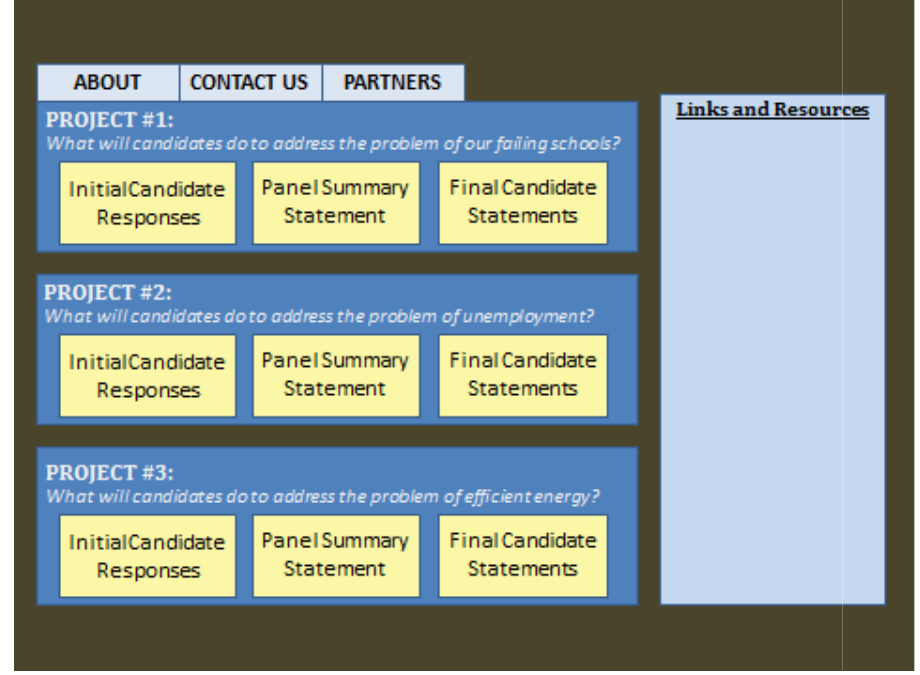
Figure 3: Final homepage